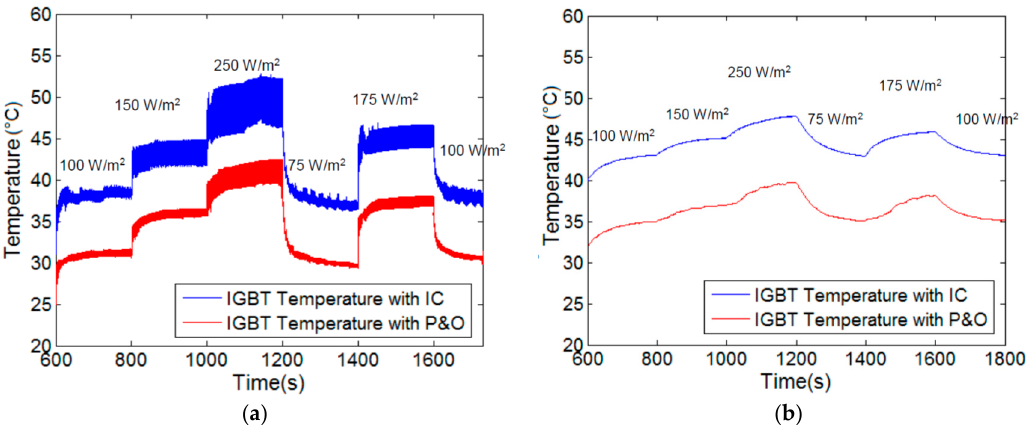
Figure 14. ( a ) Transient IGBT temperature in dSPACE; ( b ) Simulated temperature in Simulink.